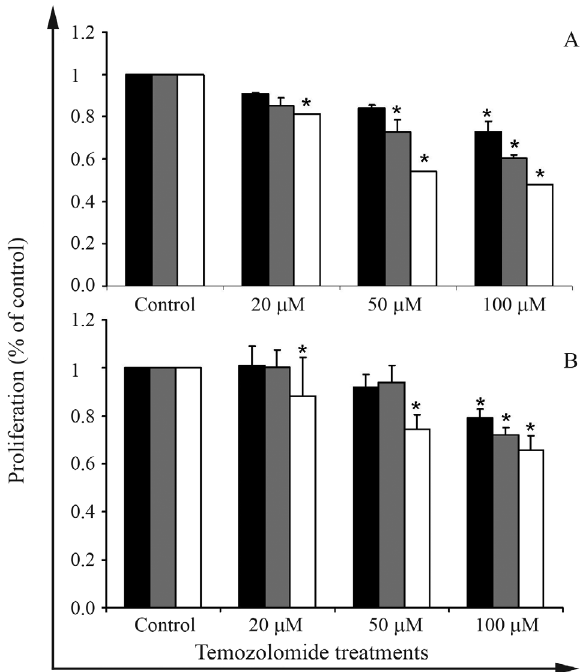
Figure 2 - Proliferation assay of cell lines treated with TMZ at the concen- trations of 20, 50 and 100 (cid:2) M, for 24, 48 and 72 h. Asterisks indicates a statistically significant difference between the TMZ-treated and the con- trol group. Figure 1 - Proliferation assay of cell lines treated with Tubi-bee propolis